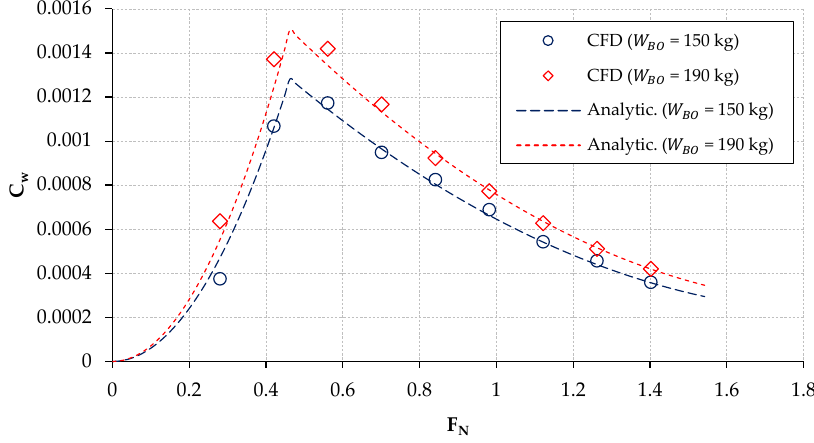
Figure 6. Wave drag coefficient of the reference demihull.